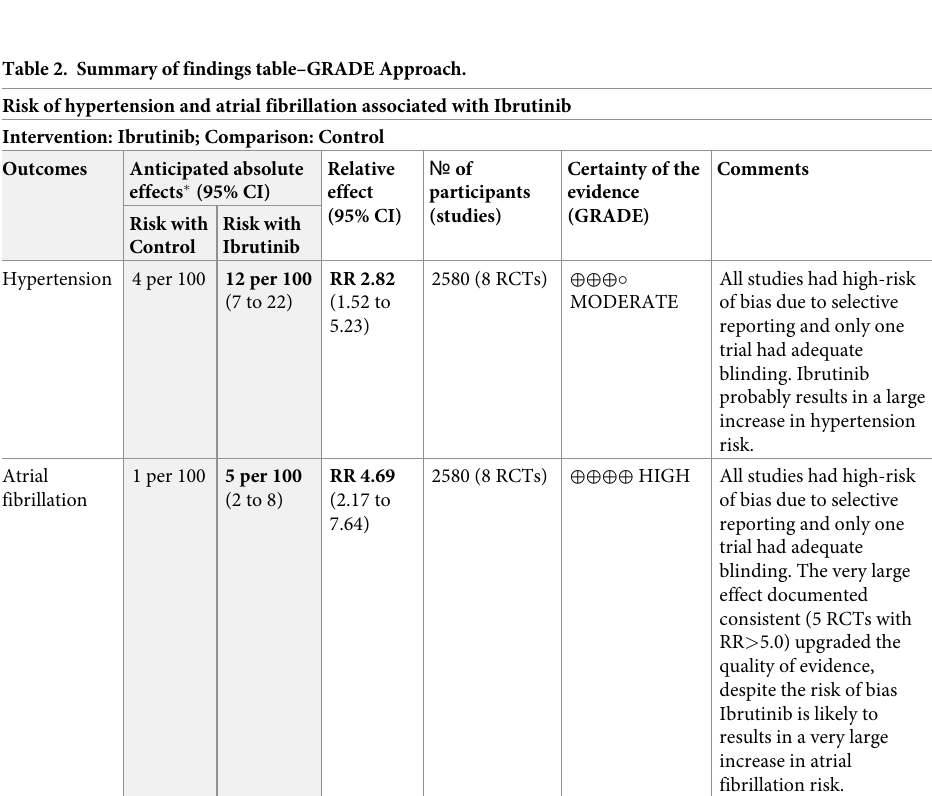
Fig 5. Forest plot with risks of atrial fibrillation associated with ibrutinib.